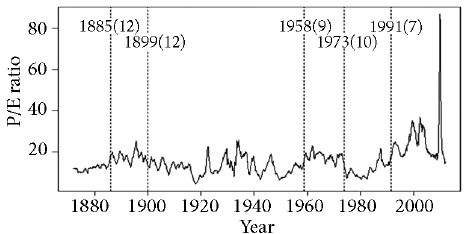
Figure 2. Structural breakpoints of PE1 – Bai-Perron algorithm